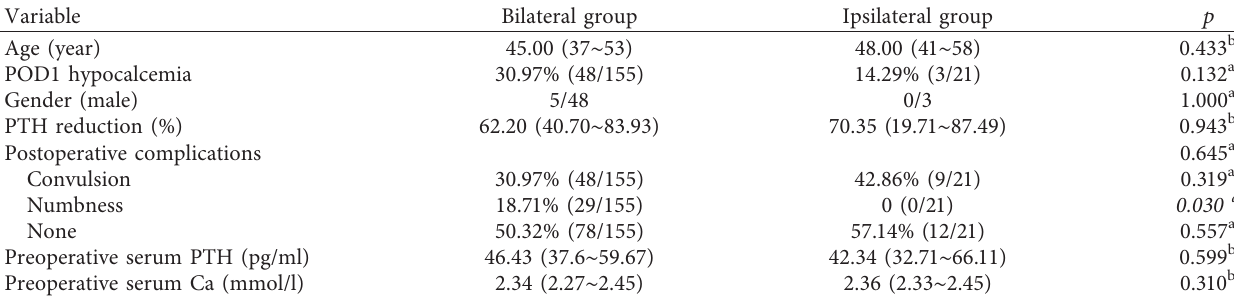
Table 3: The impact of surgical methods on the frequency of postoperative hypocalcemia and serum hormone level.